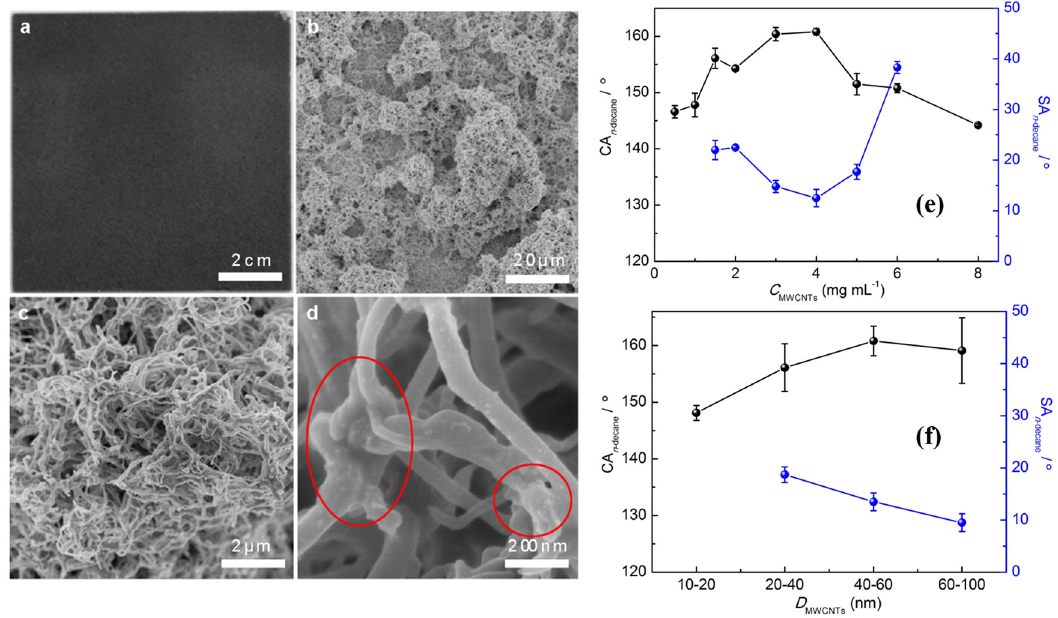
Figure 5: ( a ) Digital and ( b – d ) SEM images of the MWCNT - based composite SAPC coating. ( e and f ) CAs and SAs of n - decane on the spray - coated surface as a function of ( e ) concentration and ( f ) diameter of MWCNTs [ 106 ] . Reproduced with permission from ref. [ 106 ] ; © 2017 Elsevier